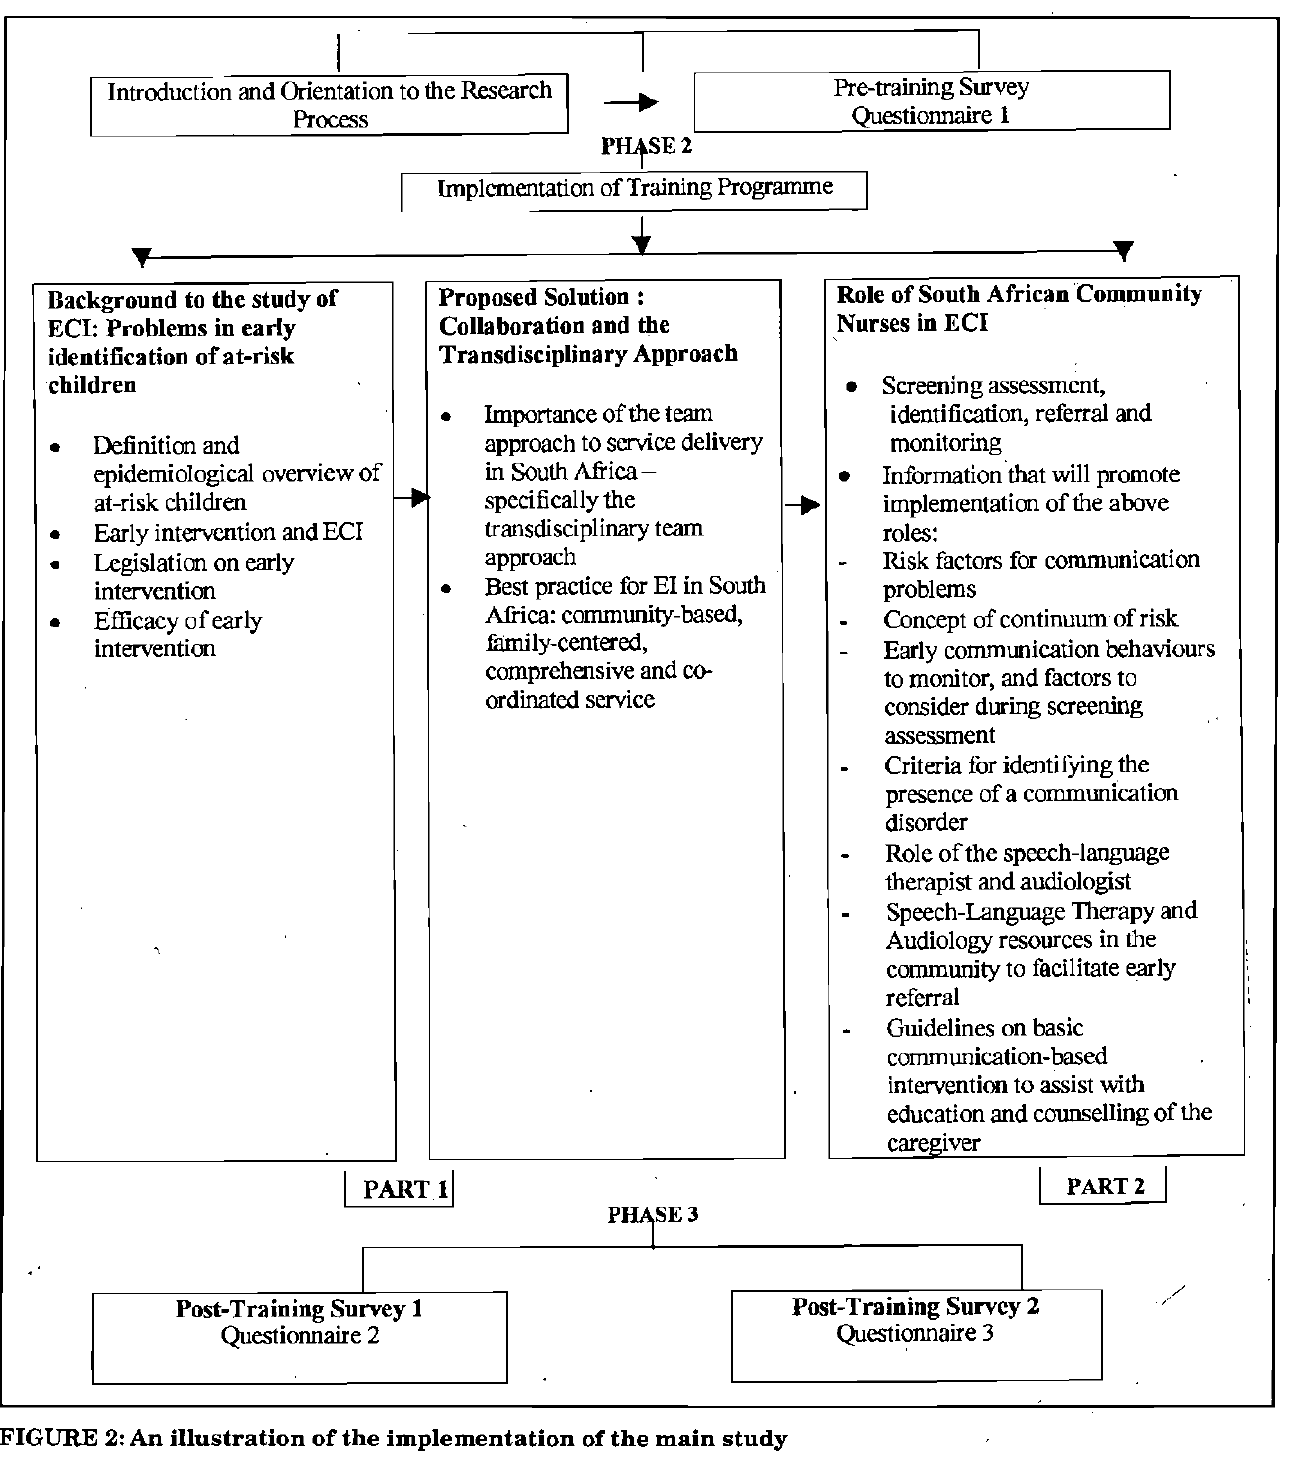
FIGURE 2: An illustration of the implementation of the main study The South African Journal of Communication Disorders, Vol. 47,